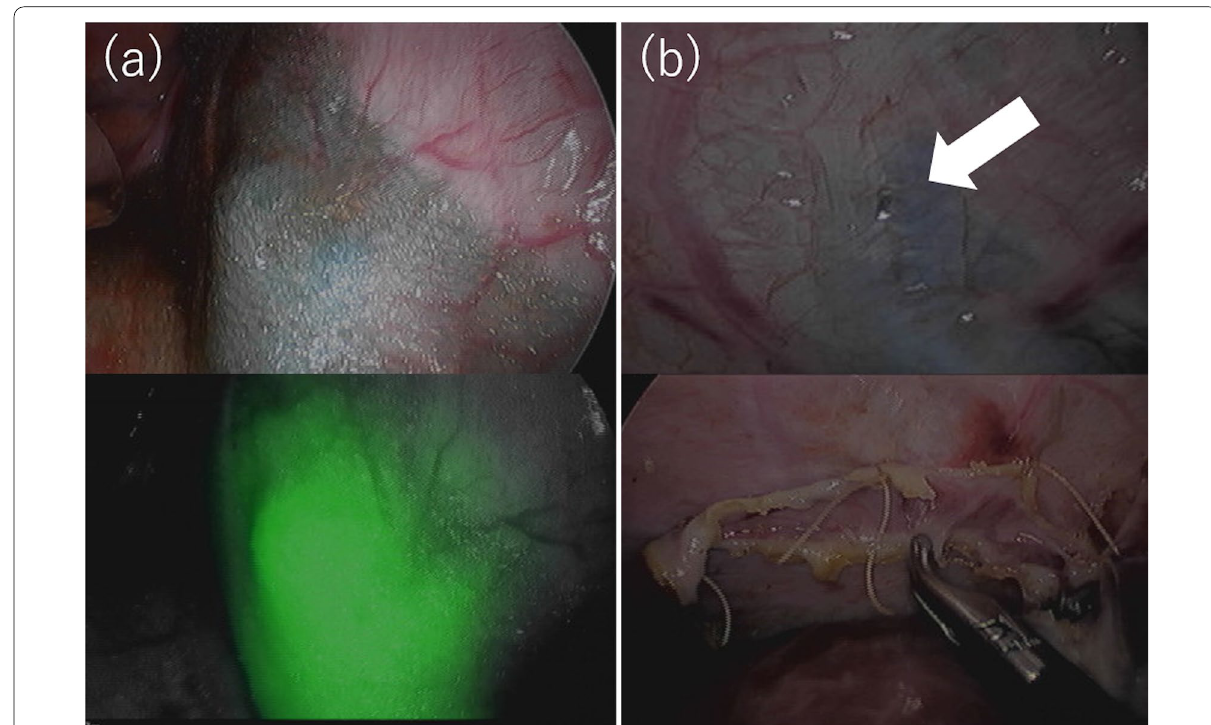
Fig. 3 After treatment findings. a After scratching the pleural surface, a sheet of absorbable polyglycolic acid felt was attached onto the cystic lesion. b The hole (arrow) was covered by suturing a falciform ligament flap patch